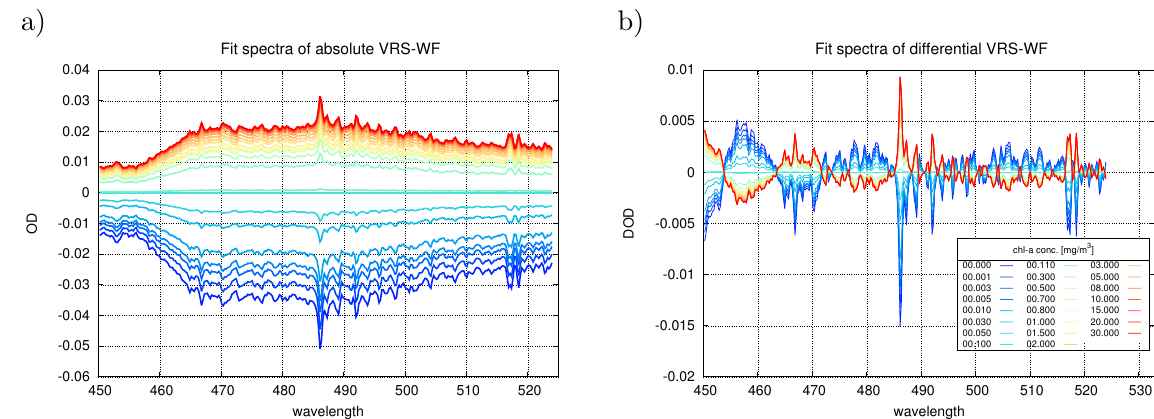
Figure 6. (a) Absolute spectral fit result (spectral optical density) of the VRS weighting function in the wavelength region of 450–524nm for different chl a . (b) Differential spectral fit result (differential optical density) which is derived by subtracting a fitted third-order polynomial.